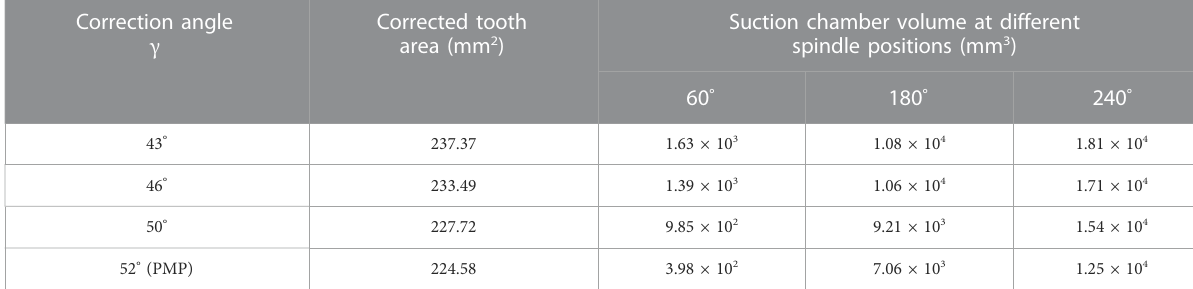
TABLE 2 Axial projection area and suction cavity volume of tooth head at different correction